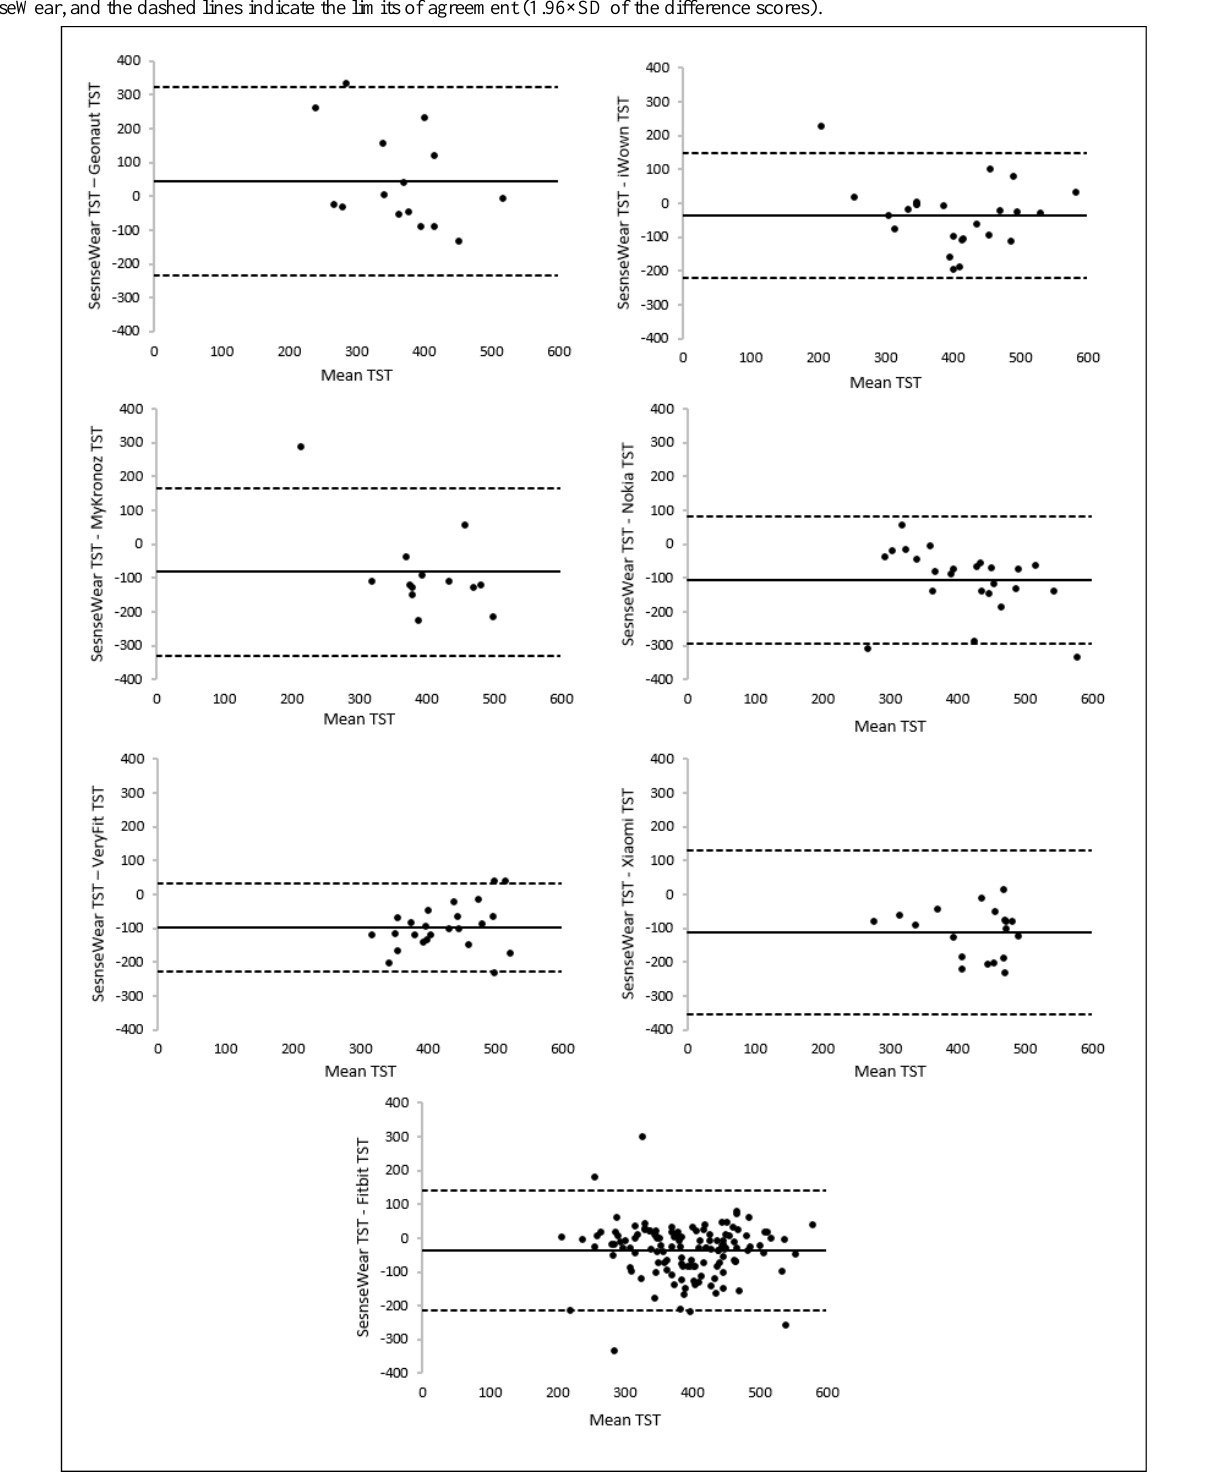
Figure 8. Bland-Altman plots of the trackers for measuring total sleep time. The middle line shows the mean difference (positive values indicate an underestimation of the wearable and negative values indicate an overestimation) between the measurements of total sleep time of the wearables and the SenseWear, and the dashed lines indicate the limits of agreement (1.96×SD of the difference